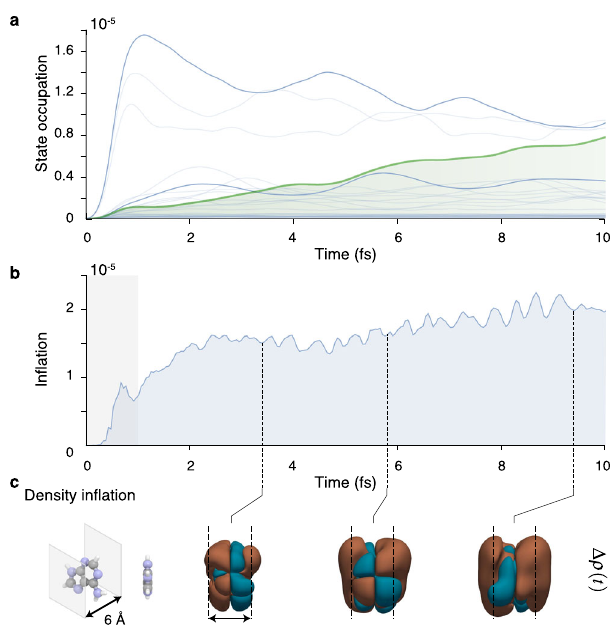
Fig. 3 Theoretical results: shake-up and charge in fl ation. a Time- dependent occupations of the adenine bound excited states after photoionisation by the XUV pulse, calculated with the ab-initio non- equilibrium Green ’ s function method. The special state (LUMO + 6), highlighted in green, is populated via the shake-up process and its population rises over several femtoseconds to one of the largest values. b Integrated time-dependent electron density more than 3 Å away from the molecular plane. The grey shaded area represents the time-window of the pump pulse, having its peak at t pump = 0.48 fs. c Left panel: the adenine molecule and the planes de fi ning the integration region. Right panel: snapshots of the variation of the electronic density with respect to the density immediately after the XUV pulse. We observe that the electronic density in fl ates considerably away from the molecular plane. The noticeable out-of-plane charge migration can be attributed to the increasing population of the correlated LUMO + 6 state (Supplementary Fig. S17). These results have been obtained with the non-equilibrium Green ’ s function